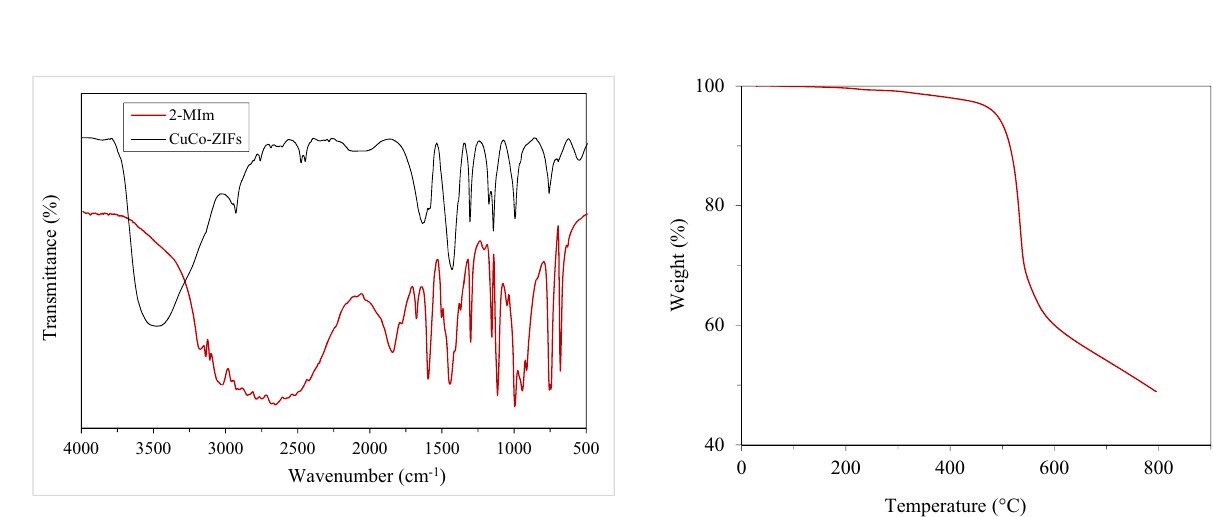
Figure A5: FT - IR spectra of CuCo - ZIFs and 2 - MIm.